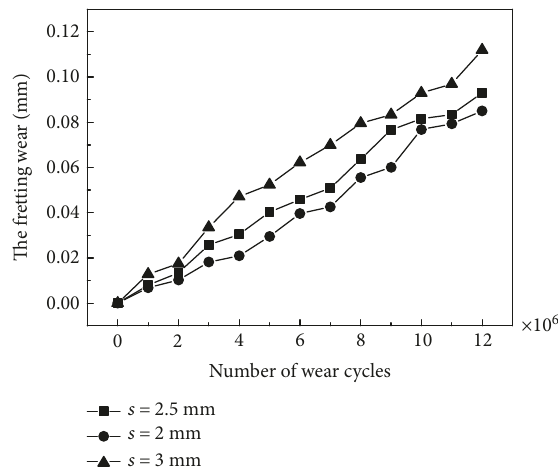
Figure 9: Wear depth results of the spline